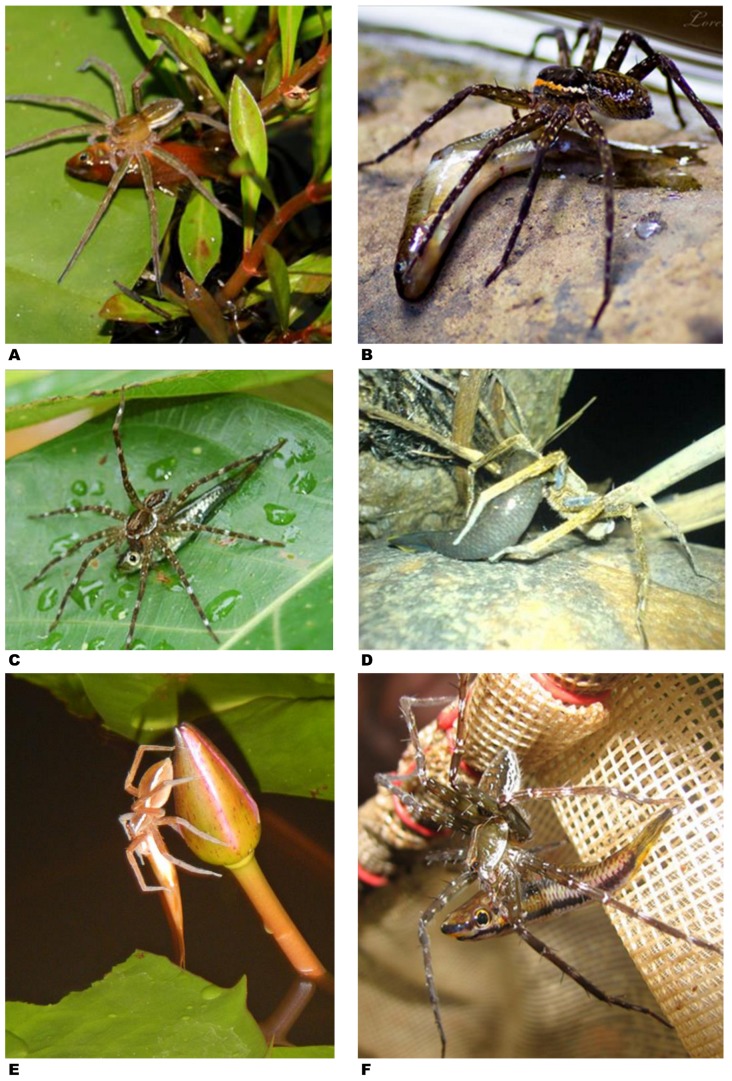
Fish caught by spiders – examples from Australia, Asia, and Africa.
A –
Dolomedes facetus captured pond fish (genus Xiphophorus) in garden pond near Brisbane, Queensland, Australia (photo by Peter Liley, Moffat Beach, Queensland; report # 67). B –
Dolomedes sp. preying on mountain galaxias (Galaxias olidus) on bank of North Branch Creek near Goomburra, Queensland, Australia (photo by Loren Jarvis, near Brisbane, Queensland; report # 66). C – Semi-aquatic pisaurid devouring fish (presumably Rasbora calliura) at edge of shallow river flowing through forest in eastern Batang Sadong basin, Borneo (photo by Michael Lo, City of Kuching, Malaysia; report # 72). D – Unspecified teleost fish captured by Dolomedes raptor on edge of stream near Tung-Shih, Taichung county, Taiwan (photo by Tai-Shen Lin, Tunghai University, Taiwan; report # 74). E – Semi-aquatic pisaurid spider (Nilus sp.), dangling from lily flower bud, pulled unidentified fish (∼4 cm in length) out of water of garden pond in Victoria Falls, Zimbabwe (photo by Marcelo de Freitas, Cresta, South Africa; report # 81). F – Pisaurid spider (Nilus sp.) in fish net attacked and captured small killifish (Aphyosemion sp.) in stream near city of Kribi, Cameroon (photo by Duncan Reid, Yale University, USA; report # 82).